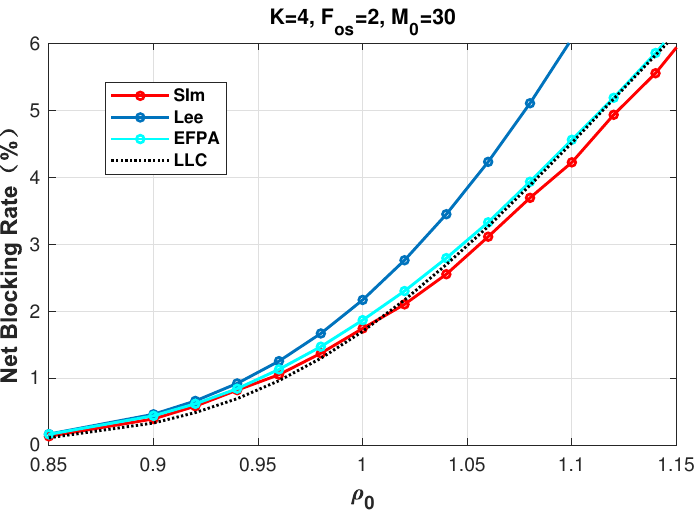
Figure 10. Network blocking performance of different methods with K = 4, F OS = 2, and M 0 =